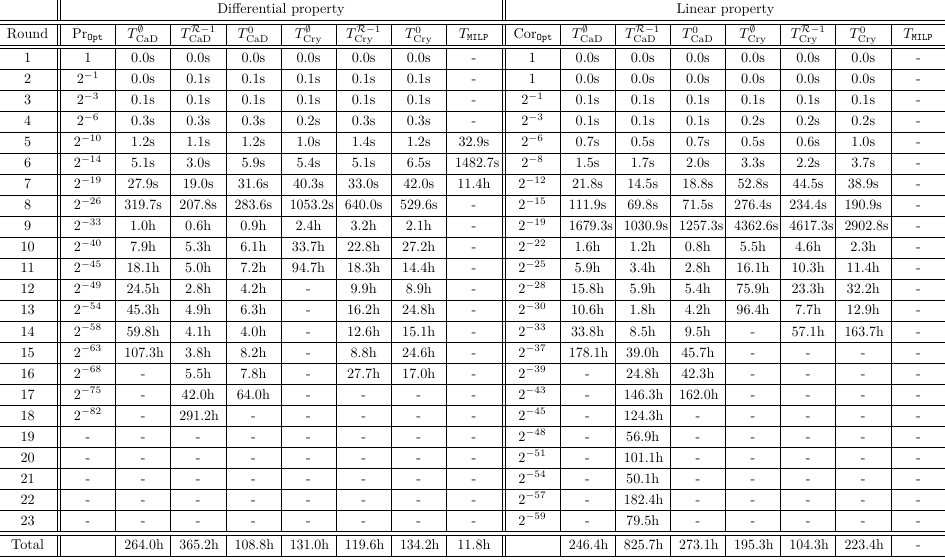
Table 18: Experimental results of SPECK48 .